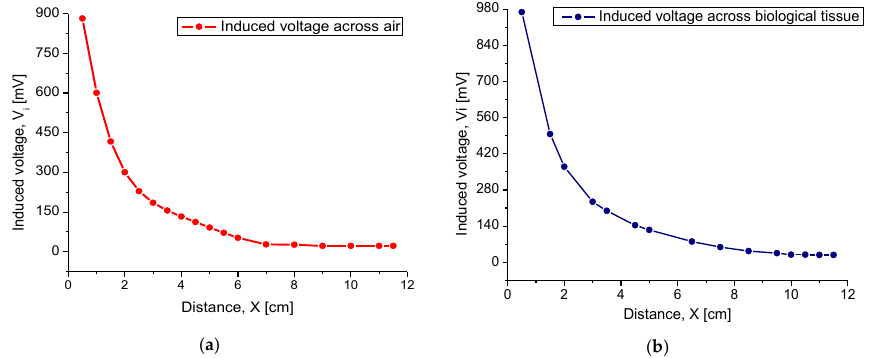
Figure 14. Induced voltage as a function of the separation distance between the coils for ( a ) air and ( b ) synthetic tissue. ( b ) synthetic